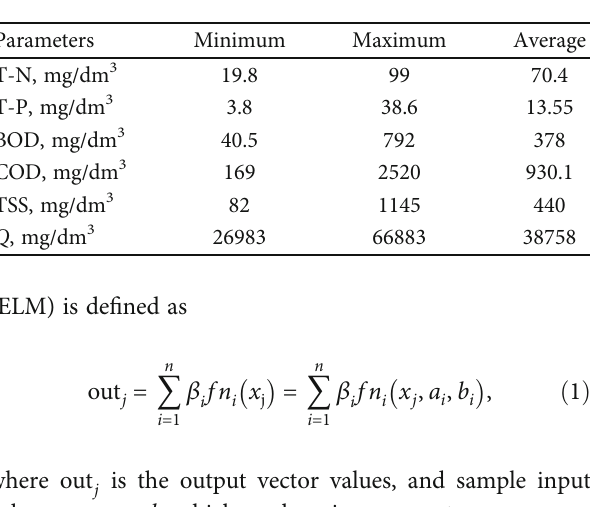
Table 3: Range of values of parameters describing in fl uent